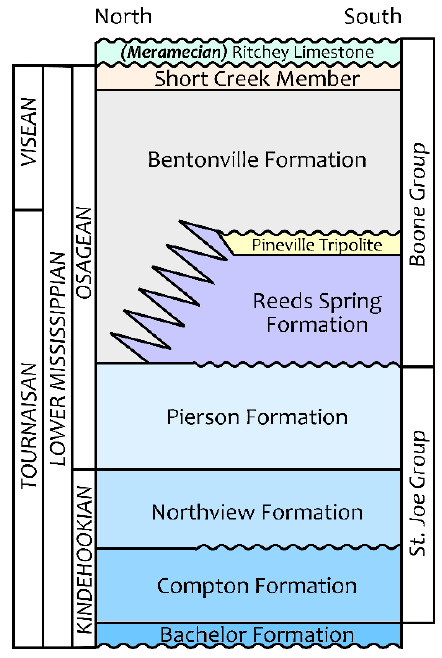
Figure 3. Generalized lithostratigraphy of Lower Mississippian subsystem in southwest Missouri, northwest Arkansas, and northeast Oklahoma, incorporating nomenclatural revisions suggested in Mazzullo et al. [25] (modified after [25,37]).